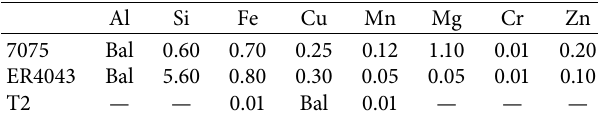
Table 1: Composition of the 7075 aluminium alloy substrate, T2 copper plate, and ER4043 welding wire